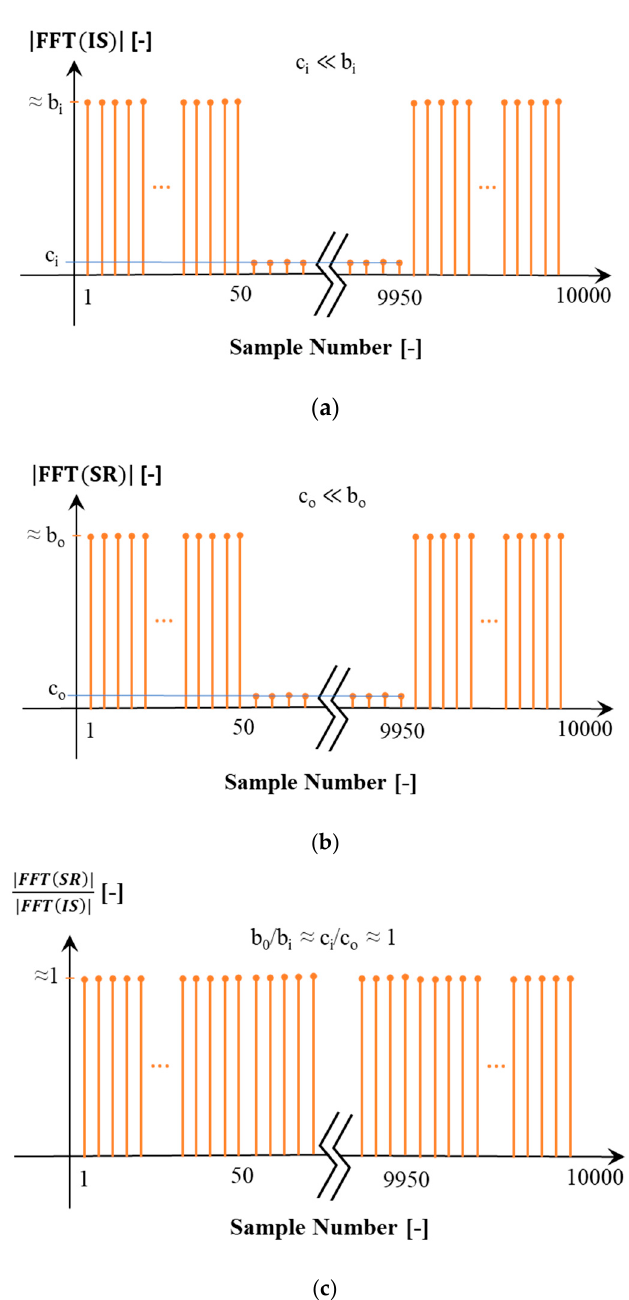
Figure 5. ( a ) DFT magnitude of the input sinc signal; ( b ) DFT magnitude of the sinc-response signal; ( c ) ratio between DFT magnitude of input sinc and sinc-response signal.